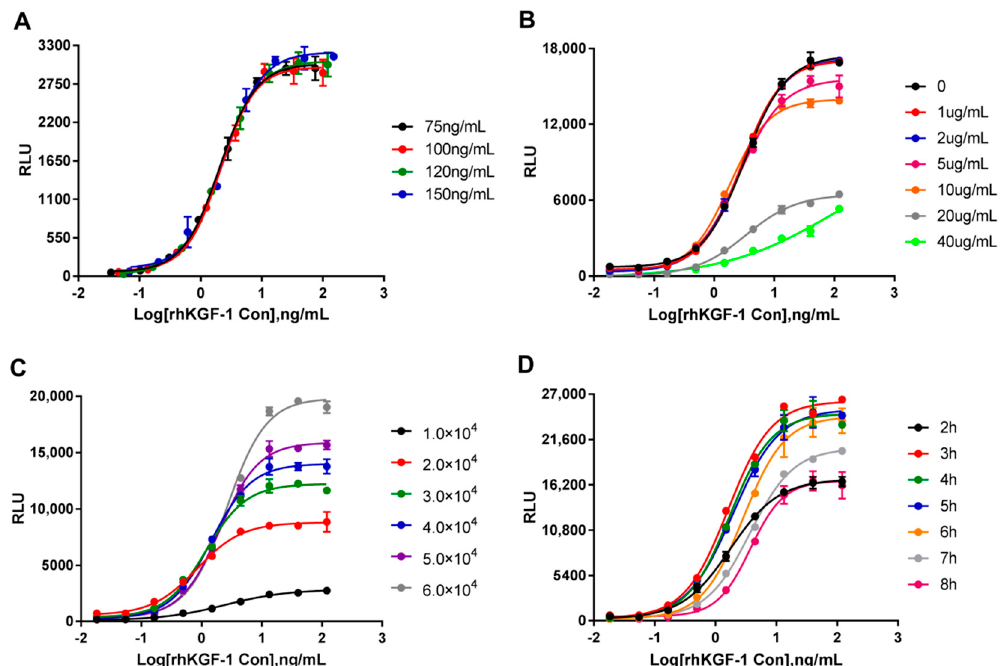
Figure 2. Optimization of parameters using responsive HEK293-Luc cells for determination of rhKGF-1 bioactivity. ( A ) The initial concentration of rhKGF-1. HEK293-Luc cells were stimulated at initial concentrations of 75, 100, 120 and 150 ng/mL with three dilution factors. ( B ) Heparin